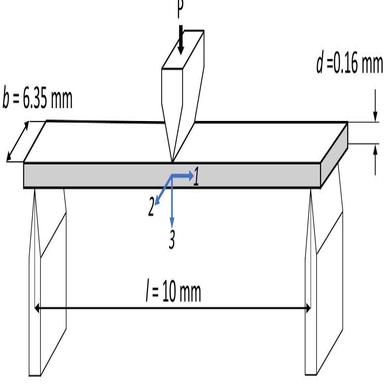
Schematic of the specimen geometry with orthogonal coordinate system; Coordinate direction 1 is along fiber direction, direction 2 is in the width direction perpendicular to the fibers and direction 3 is across the specimen thinckness.. The origin of the coordinate system is at mid-span of the specimen.